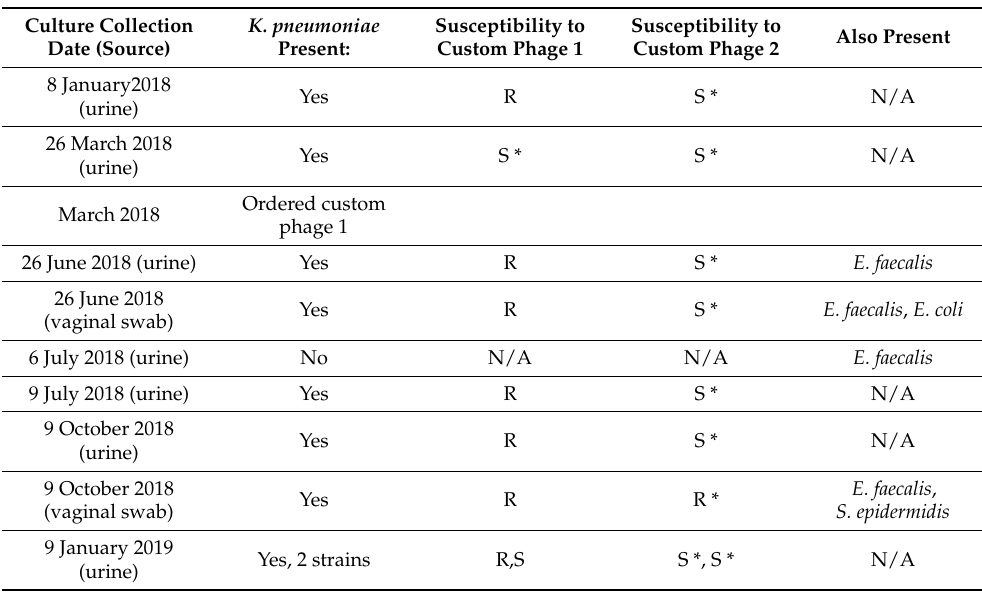
Table 4. Urine and vaginal swab cultures of patient #3: strain sensitive to phage (S), strain resistant to phage (R). Phage susceptibility marked with asterisks applies to the strains that were isolated before custom phage